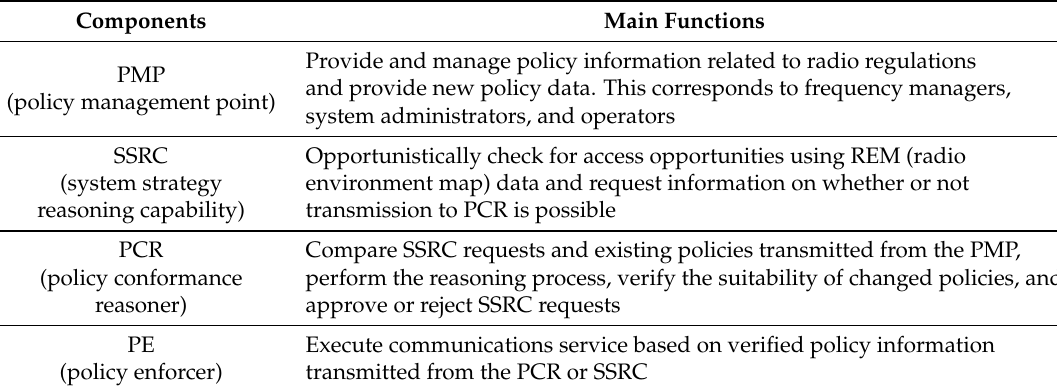
Table 1. IEEE P1900.5 standard’s cognitive radio engine components